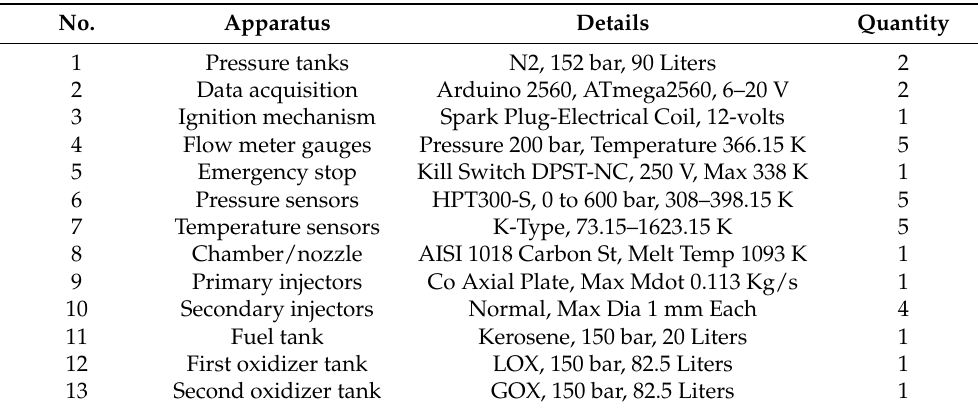
were integrated and programmed on the Vero Board. Figure 15. Arduino Mega 2560 integrated on Vero board for data acquisition. Thermocouples, which are electrical devices, were used to obtain the temperature profiles at the aft section of the engine. The most common type of thermocouple is the “K - Type” (chromel– alumel) thermocouple, which was used for this experiment. The K-Type is the most commonly used general-purpose thermocouple, with a sensitivity of approxi- mately 41 μ V/°C. The K-Type thermocouples were readily available in the propulsion lab, and they fulfilled the required range of temperature variation from − 200 °C to +130 °C (73.15 K to +1623.15 K) needed for the experiment. To measure the pressure profile, piezoelectric pressure sensors “HPT300 -S Universal Pressure Sensors by Holykell Technology” were used in the experiment. The reason for choosing HPT300-S for measuring pressure is its rugged design. It also provides vibration resistance, and shock resistance, has a wide range of temperature variations, and is suita- ble for other extreme environmental conditions. At standard conditions (ambient temper- ature: 25 °C), the working pressure and temperature of HPT300-S sensors are 0 bar – 600 bar and 35 °C to +125 °C (308.15 K to +398.15 K), respectively, while the measuring error and accuracy are approximately 1.0 to 3% F.S. The HPT300-S sensors were lightweight, small in size, easy to install and operate, and fulfilled experimental requirements, so they were considered for the experiment. Figure 16, below, shows both thermocouples and pressure sensors.